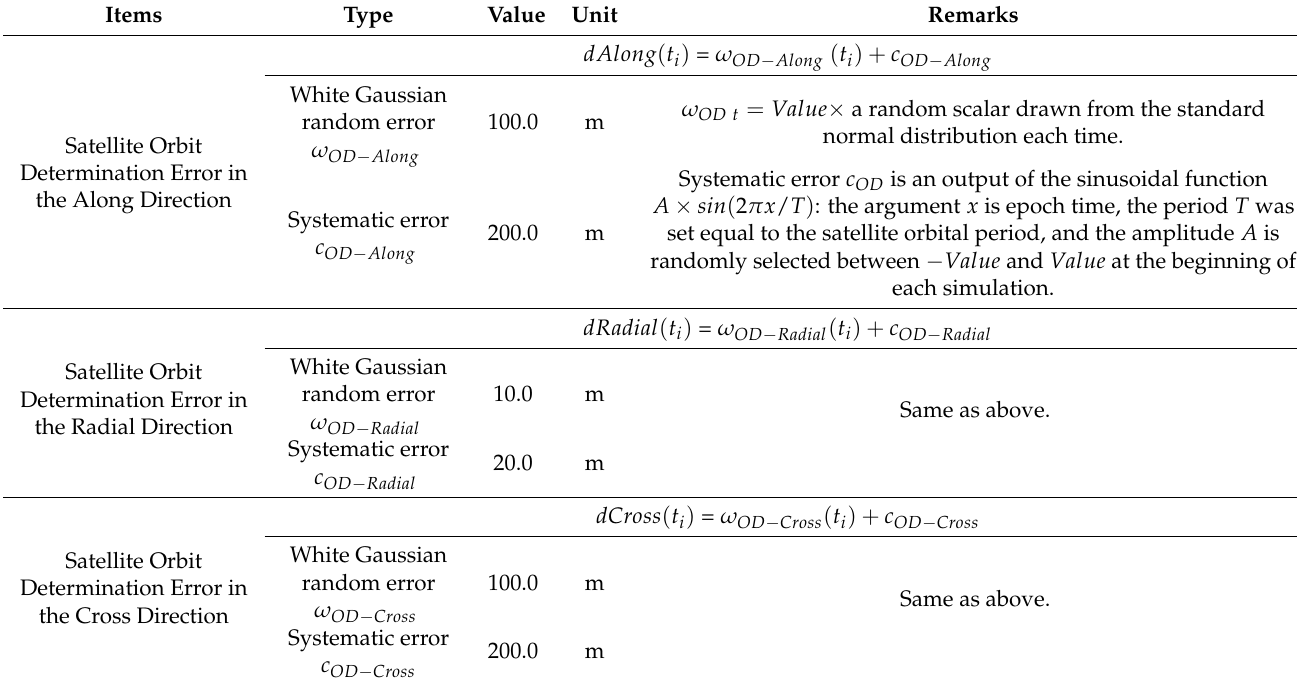
Table 6. Overview of the satellite orbit determination error used in the